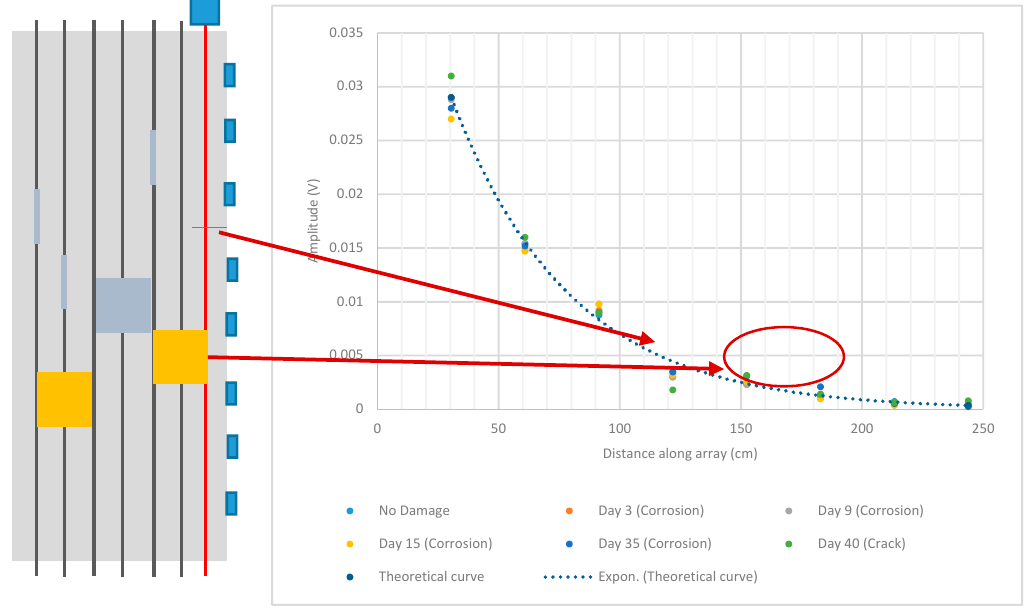
Figure 15. Amplitude versus distance plot for Specimen Set 2 using 2 inch transducers as sensors (array of eight sensors) when the transmitter is placed on the far-right rebar.